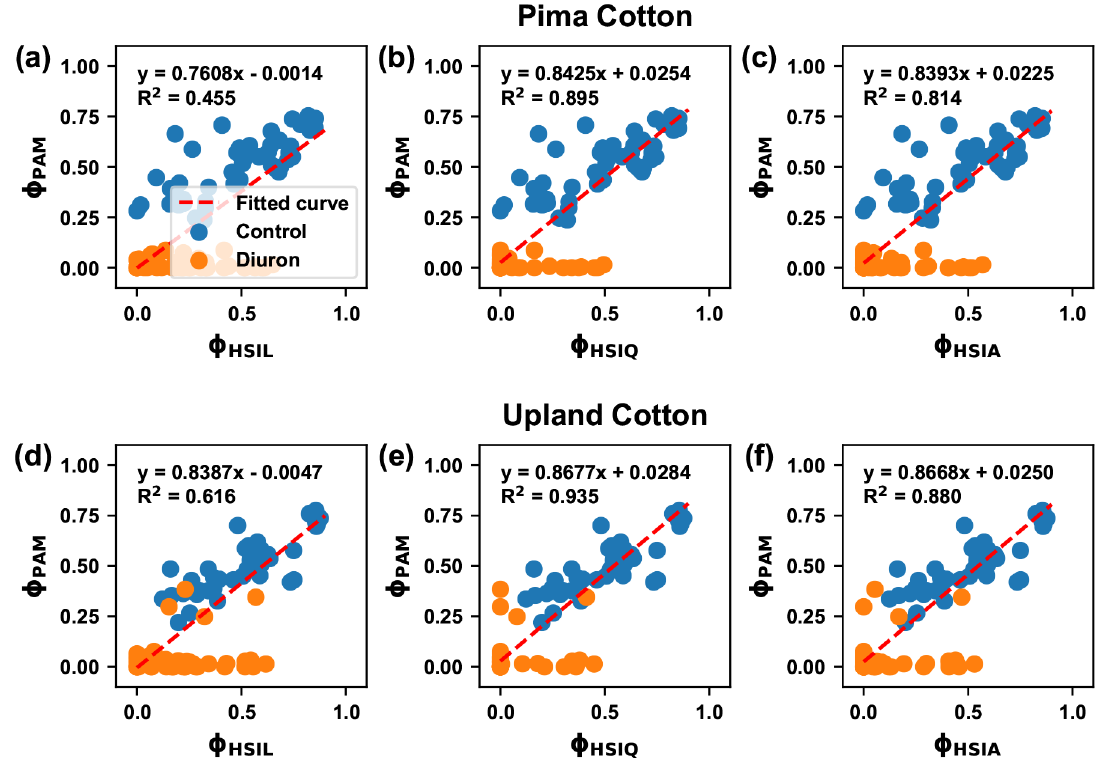
Figure 6. Coefficient of determination ( R 2 ) between the effective quantum yield of PSII ( φ PSII ) values derived from PAM and HSI data: ( a – c ) are for the Pima cultivar and ( d – f ) are for the Upland cultivar. φ PAM indicates values calculated using PAM data. φ HSIL , φ HSIQ , and φ HSIA indicate values derived from hyperspectral data using the maximal fluorescence value estimated by the linear, quadratic, and average models. It is noteworthy that to avoid potential effects due to outliers, all R 2 values were obtained from least-squares linear regression analyses with robust option (“bisquare”) in